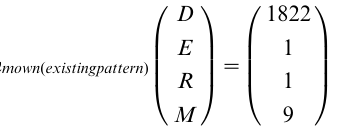
Figure 2. Long-term dynamics of different demographic stages of feral alfalfa populations under existing mowing and non-mown scenarios with non-subsidised, local recruitment. X axis indicates the duration of simulation (i.e. 100 years) and Y axis represents the